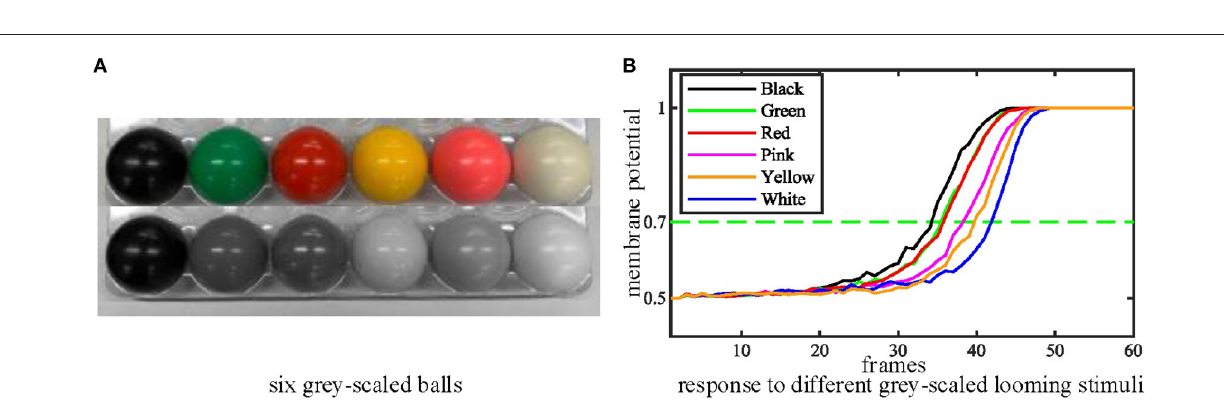
per second. The red arrow in Figure 12A is the direction of rotation. Our results in Figure 12B show that when the camera rotates violently, the FFI mechanisms in MLG1 neurons have been activated immediately. Thus, there are no spikes in